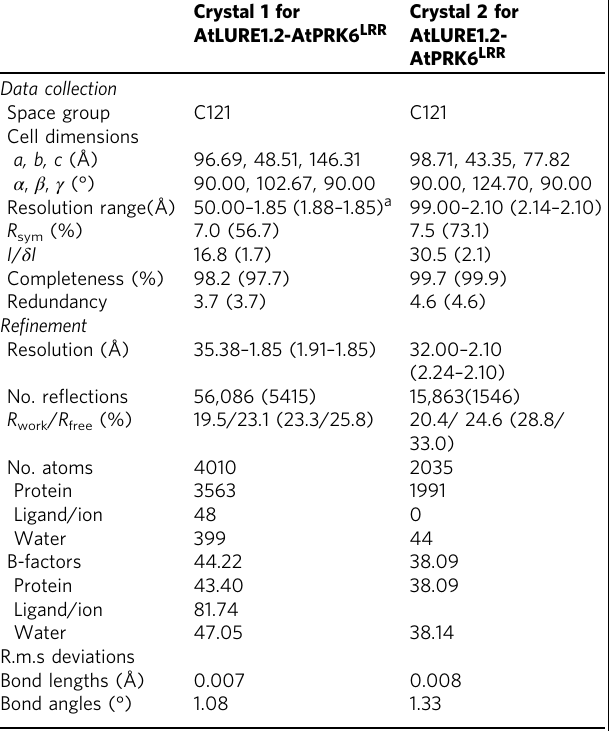
Table 1 Data collection and re fi nement statistics Crystal 1 for Crystal 2 for AtLURE1.2-AtPRK6 LRR